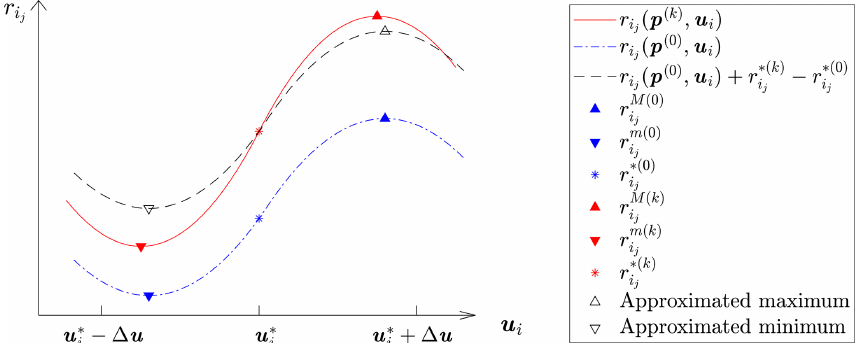
Figure 1. Approximation of the maximal and minimal